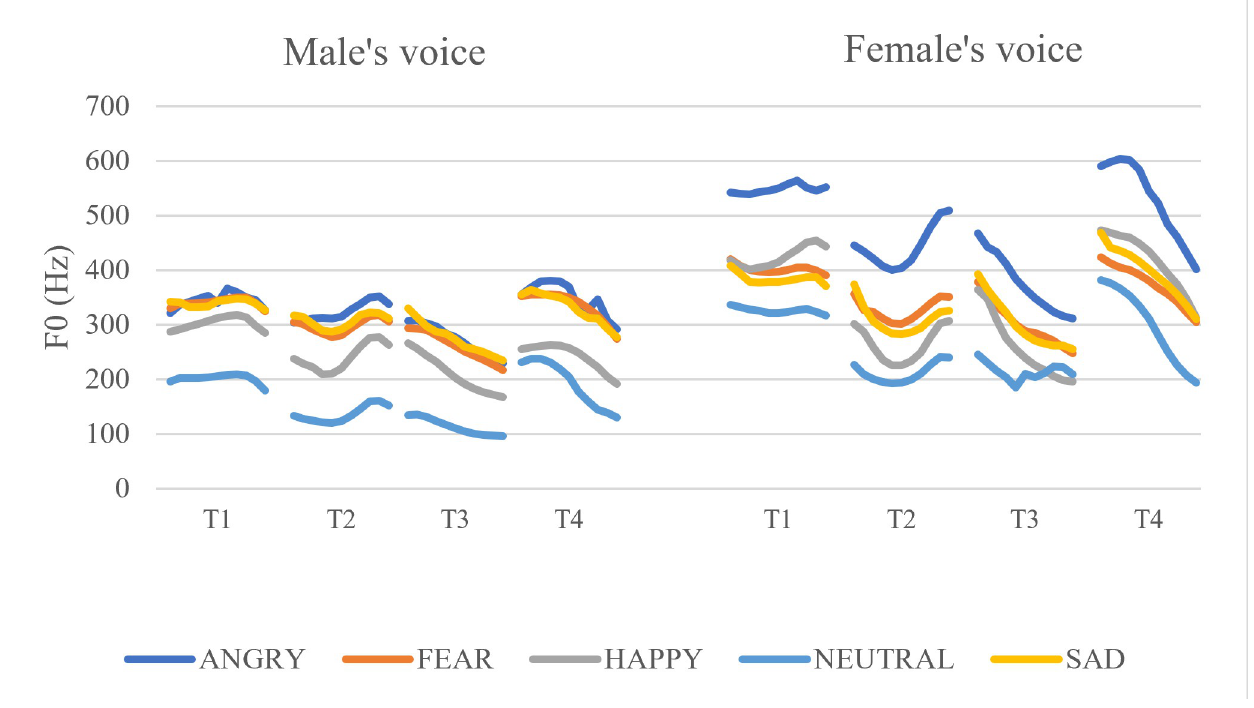
Fig 1. F0 contours of target syllables as a function of emotion, Mandarin tone, and talker